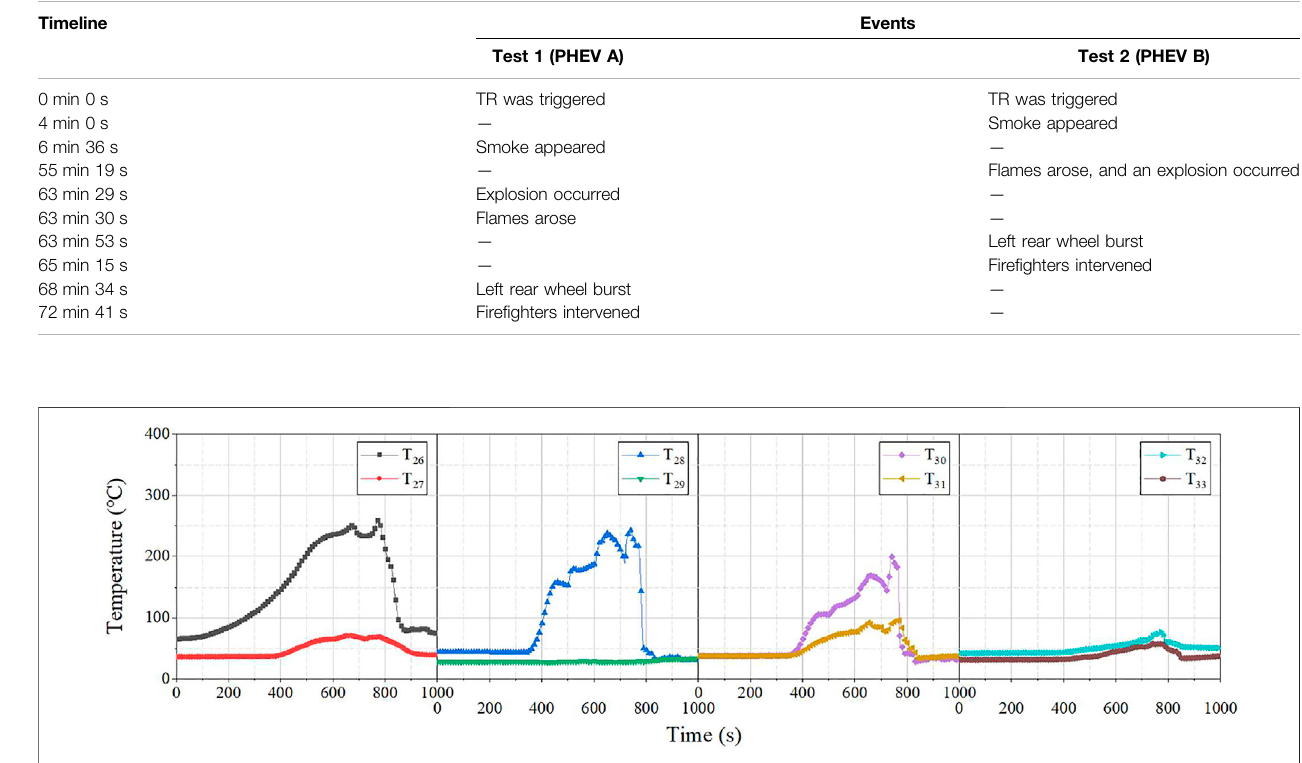
FIGURE 10 | Temperature evolutions in the compartments of PHEV B.